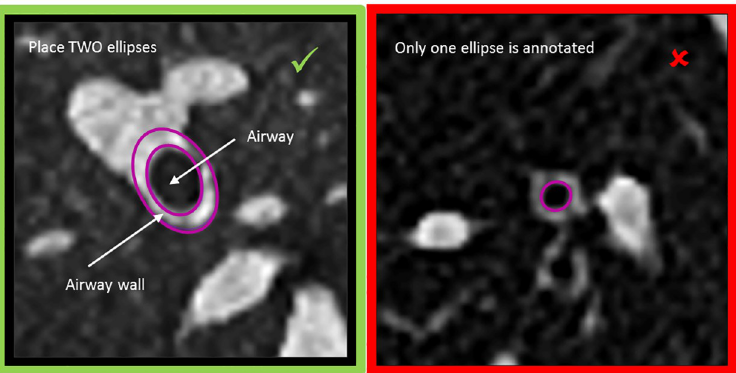
Fig 2. First set of instructions provided to the workers. One more set of instructions was available, but this was the set that all workers would see.